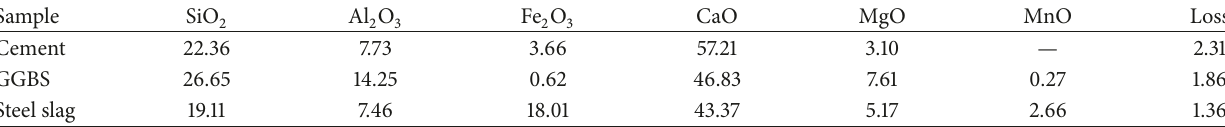
Table 1: Chemical compositions of the cement, GGBS, and steel slag (%).